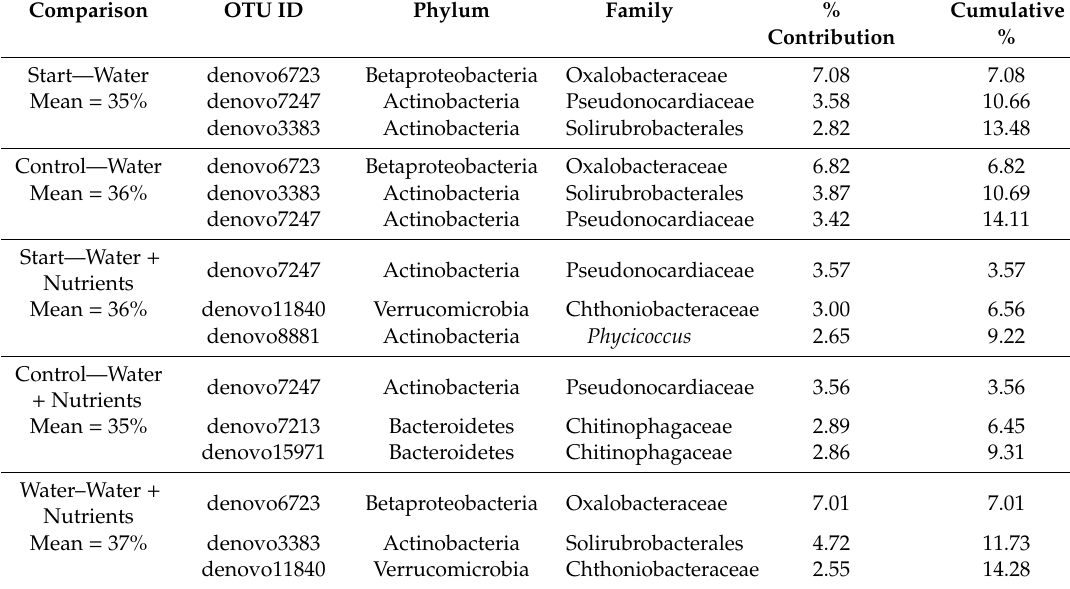
Table 1. Similarity percentage analysis (SIMPER) among microcosm treatments for 16S data. For each comparison, the unique OTU identifier, phylum, family, percent contribution to dissimilarity and cumulative percent contribution to dissimilarity are shown for the top three taxa contributing to the